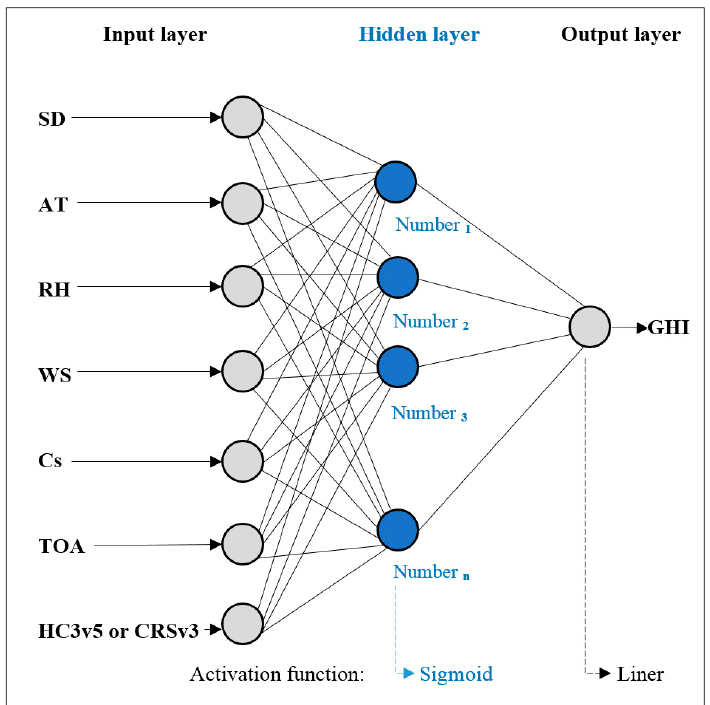
Figure 2. ANN architecture description.